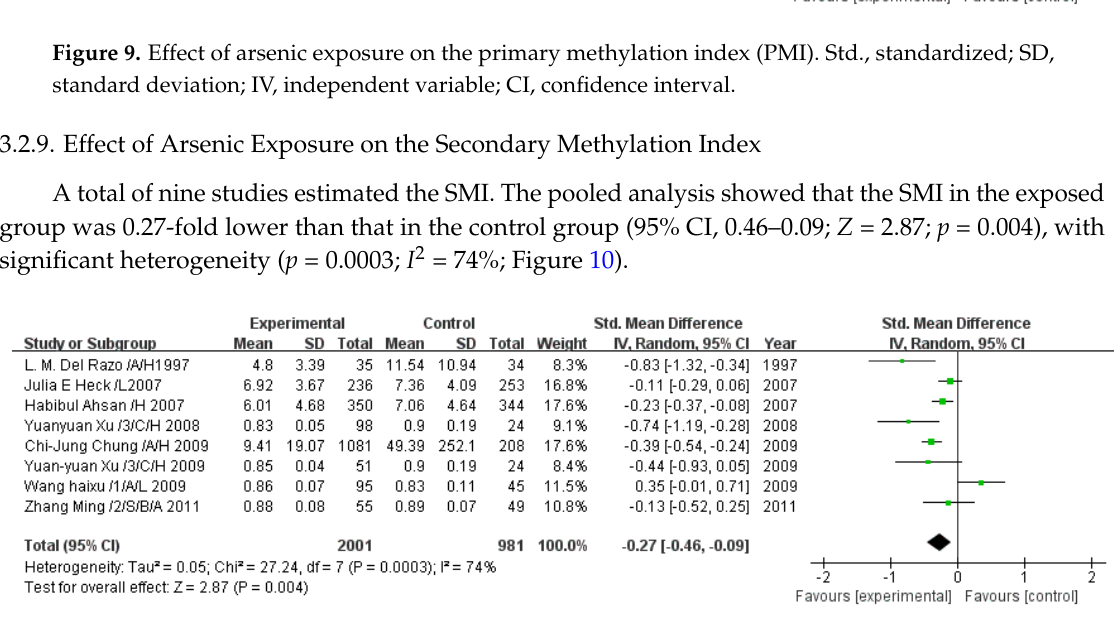
Figure 10. Effect of arsenic exposure on the secondary methylation index (SMI). Std., standardized; SD, standard deviation; IV, independent variable; CI, confidence interval